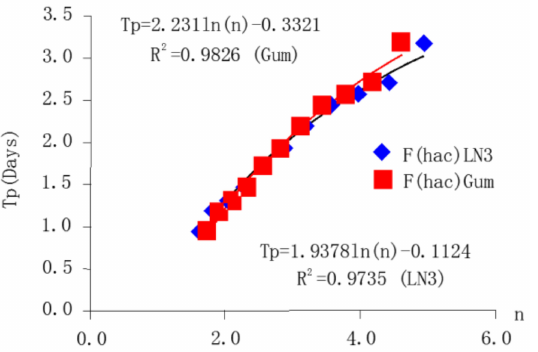
Figure 6. Fitting results between estimated weather window duration and threshold heights h ac